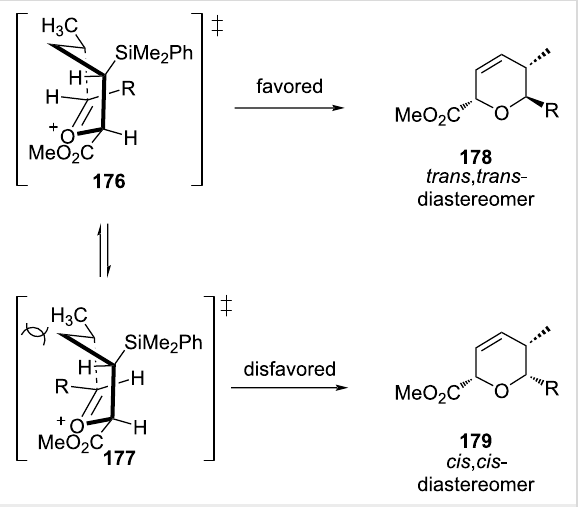
Scheme 43: Panek and Huang’s DHP synthesis from anti -crotylsi-